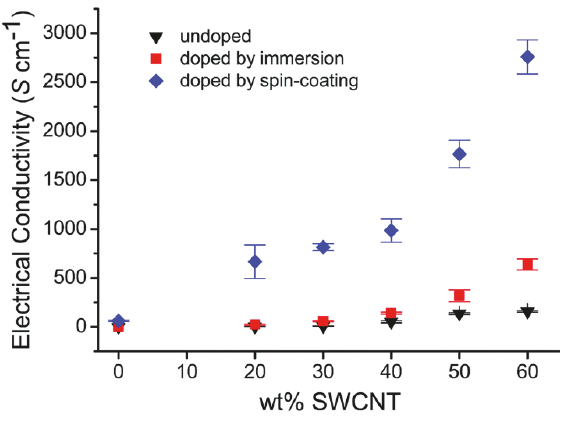
Figure 15: Electrical conductivity of the SWCNT-P3HT hybrid films,inwhichtheP3HTmatrixwasundoped,dopedbyimmersion, and doped by spin-coating, as a function of the mass fraction of SWCNT. Figure is reproduced with permission [211].